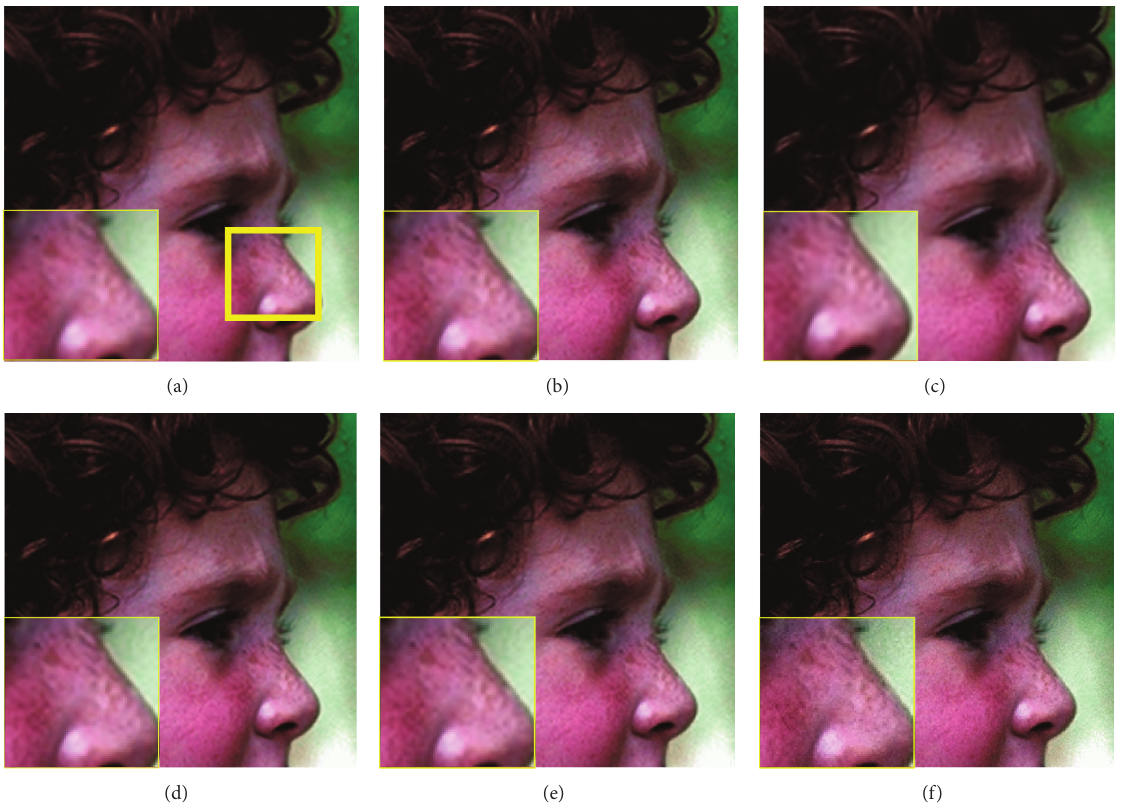
Figure 7: The comparison of the proposed algorithm and four other methods on 𝑔𝑖𝑟𝑙 image (2x), and the local magnification in yellow rectangle is shown in the lower left corner in each example. (a) Bicubic. (b) Zeyde et al. [12]. (c) Yang et al. [16]. (d) ANR [15]. (e) Our proposed. (f) Original.